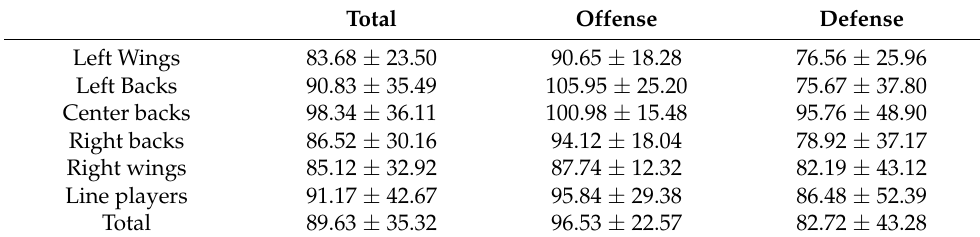
Table 4. Running pace (m/min) in the entire game, offense, and